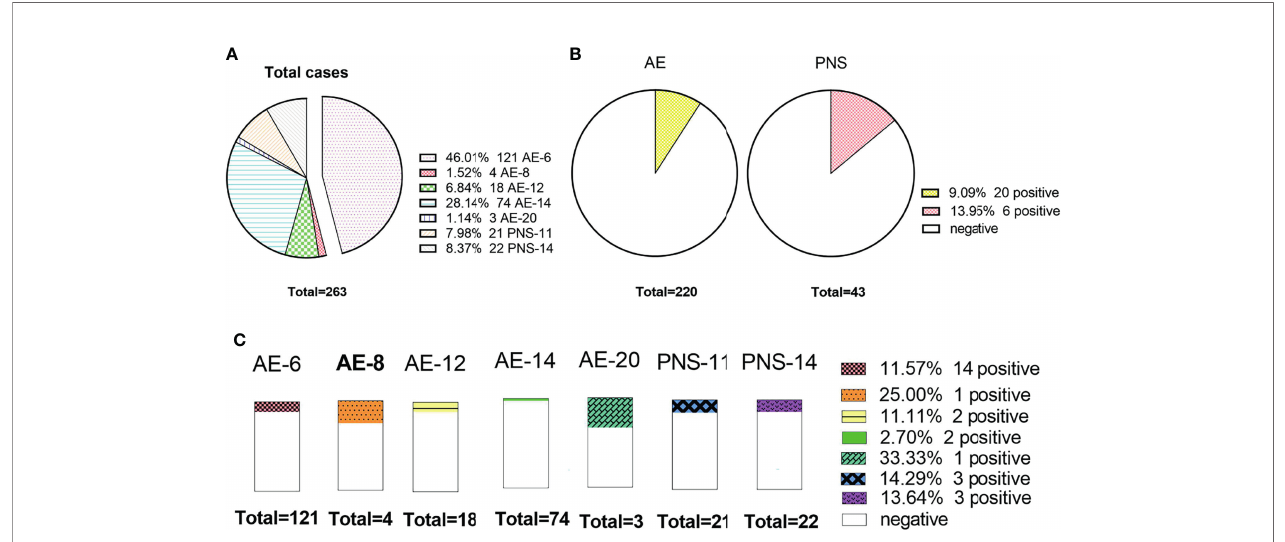
FIGURE 6 | The status of AE antibody among different package items. (A) The number of cases detected by different packages; (B) The comparison of the positive rate between the AE and paraneoplastic syndrome packages; (C) The distributions of the positive rate among different package